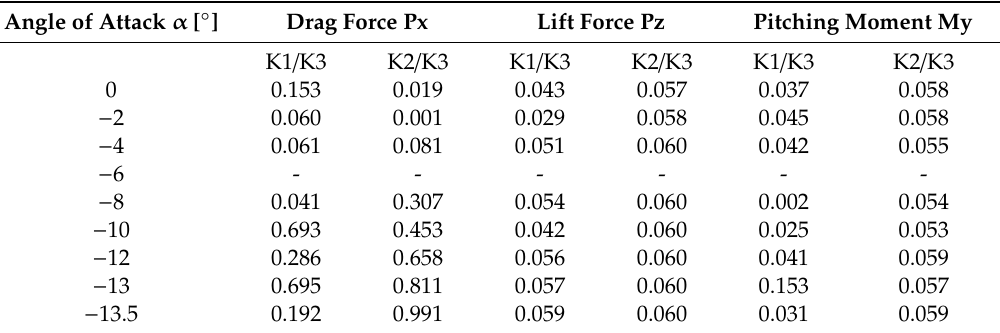
Table 2. Test results of significance of changes in the drag force, lift force and pitching moment My among the considered configurations. Angle of Attack α [ ◦ ] Drag Force Px Lift Force